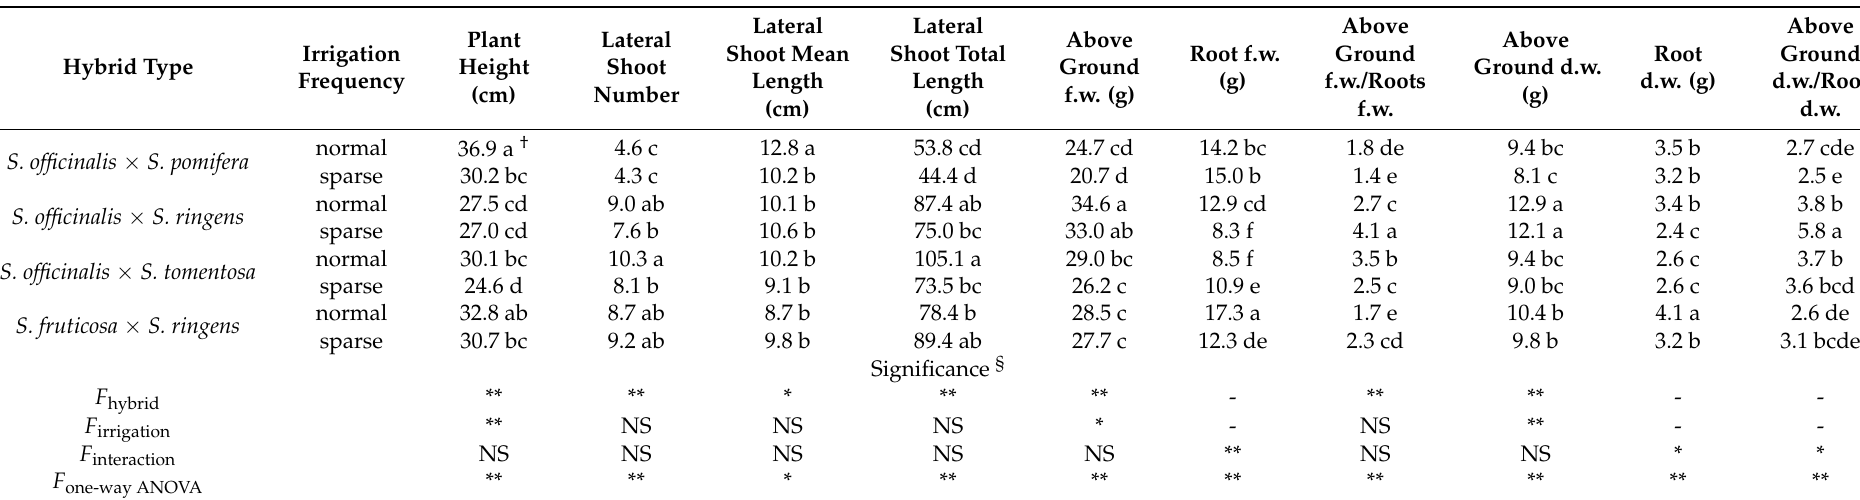
Table 4. Comparative evaluation of growth of four new interspecific hybrids of Greek sage species regarding resistance to water deficiency, after three months of greenhouse culture on peat: perlite 2:1 ( v / v